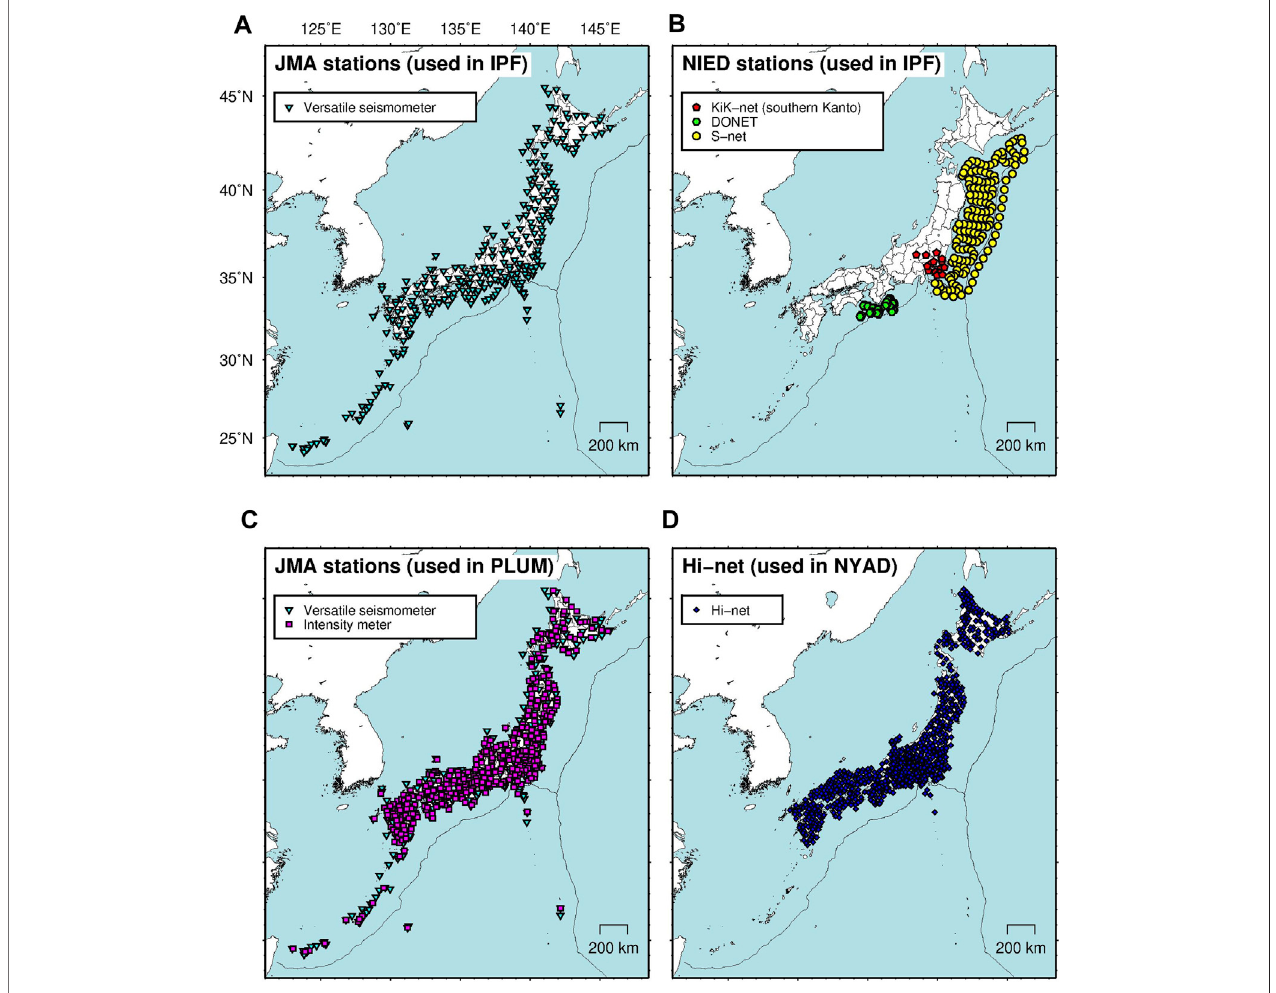
FIGURE 2 | Locations of (A) JMA stations used in IPF, (B) NIED stations used in IPF, (C) JMA stations used in PLUM, and (D) Hi-net stations used in